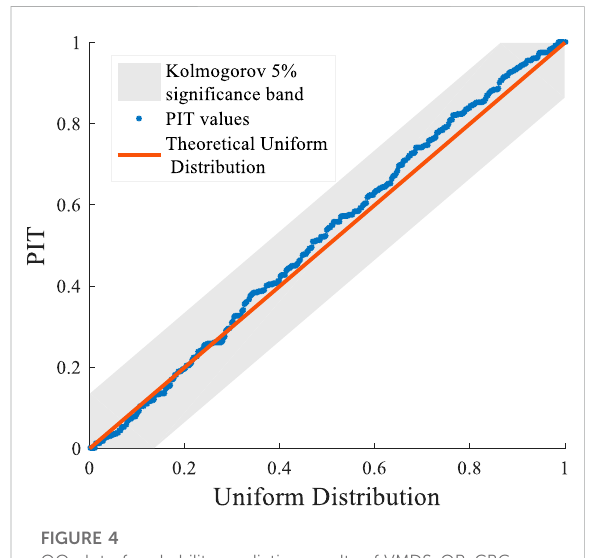
FIGURE 4 QQ plot of probability prediction results of VMDS-QR-CBG.